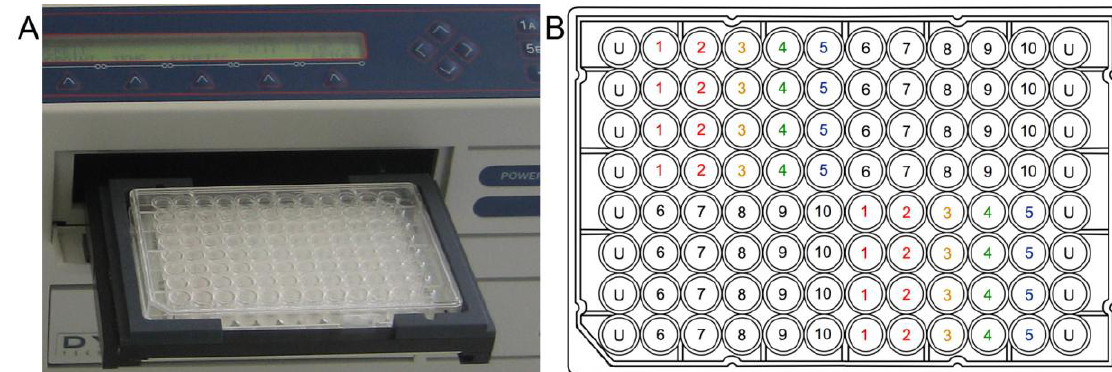
FIGURE 2 . (A) Microplate with 96 wells in the drawer of the automated microplate reader. (B) Spatial arrangement of the ten coded samples on the microplate, as measured in one experiment (five potency levels of a given substance and five water controls [three succussed and two unsuccussed]). In every verum experiment, the coded samples were newly randomly allocated to the fixed blocks. In the case of systematic negative control experiments, samples 1–10 were of identical origin (distilled water). Wells of both outer columns (U) were filled with unimpaired yeast (without arsenic[V]). These uncoded samples were used for calculation of the degree of damage only and did not enter the statistical analysis of the coded